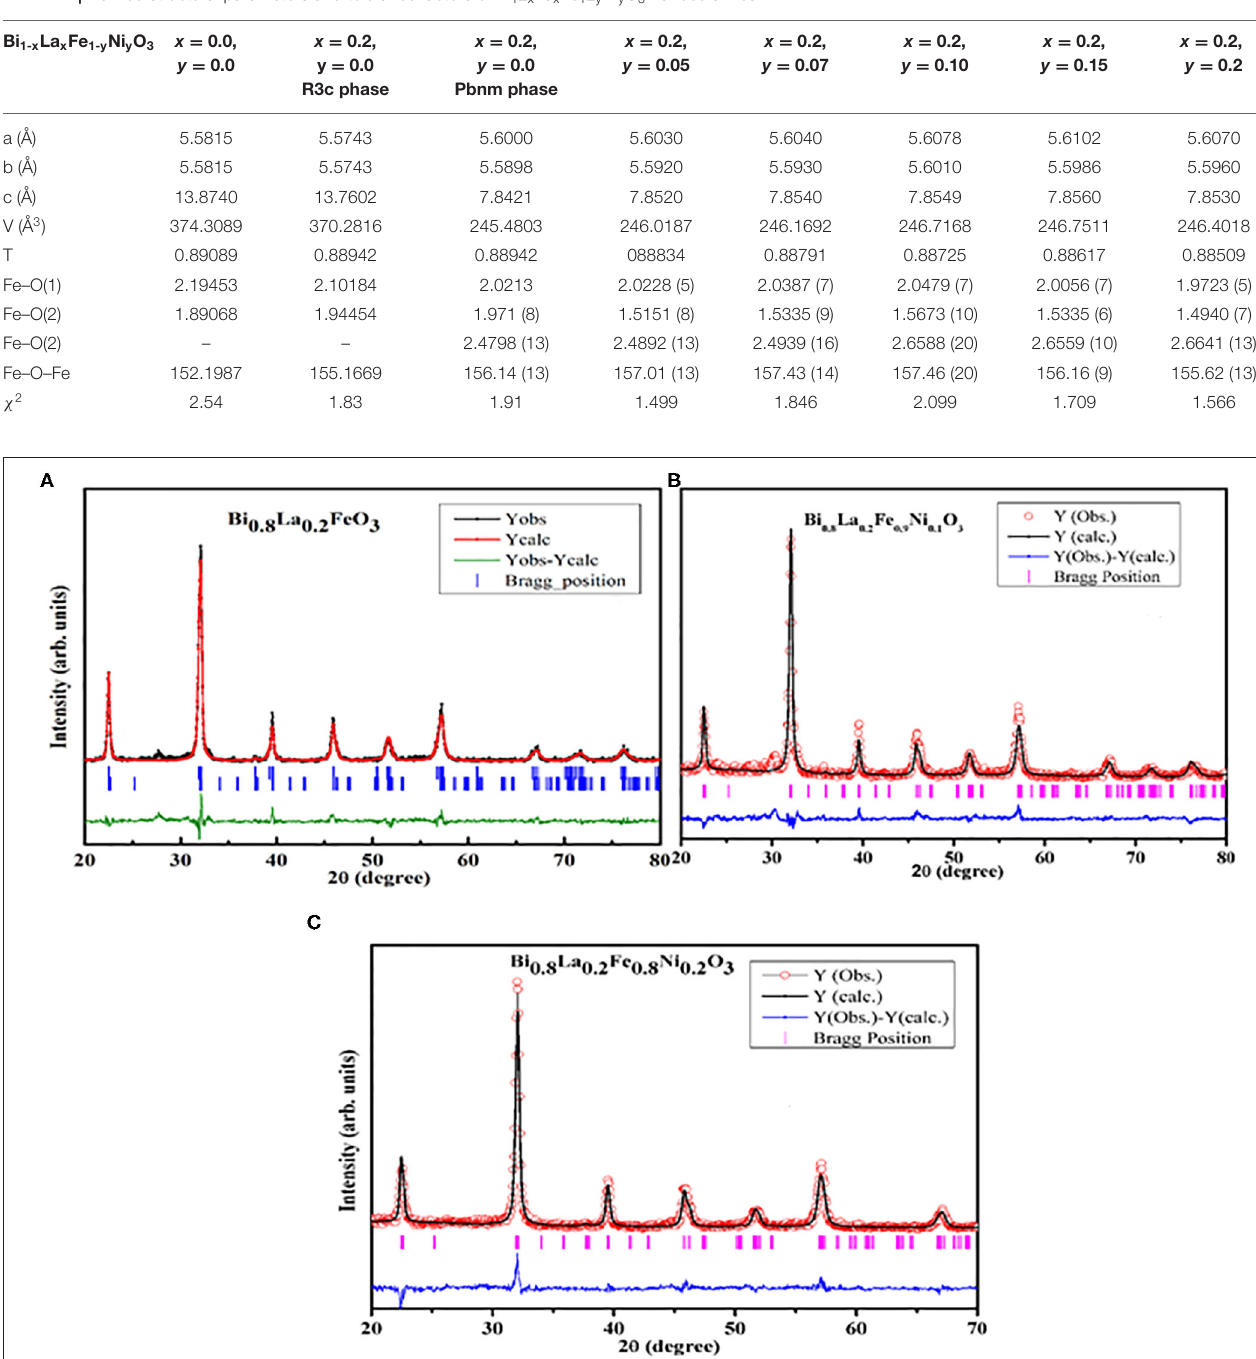
La x Fe 1 Ni y O 3 nanoceramics. − x − y